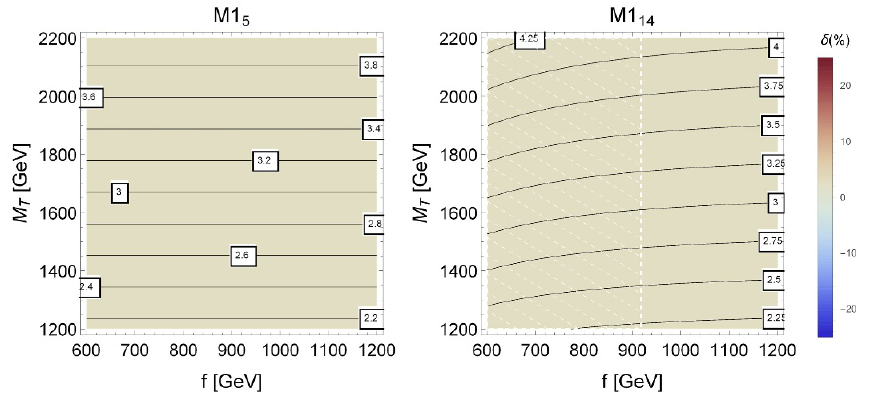
Figure 8 . The contour plots of (cid:14) ( p cut ) with sin 2 (cid:18) L = 0 : 1 and p cut = 200 GeV for each of the T T singlet models with one top partner multiplet. The solid lines correspond to constant values of the coupling y . The region marked by dashed white lines indicates when (cid:20) t (cid:20) 0 :